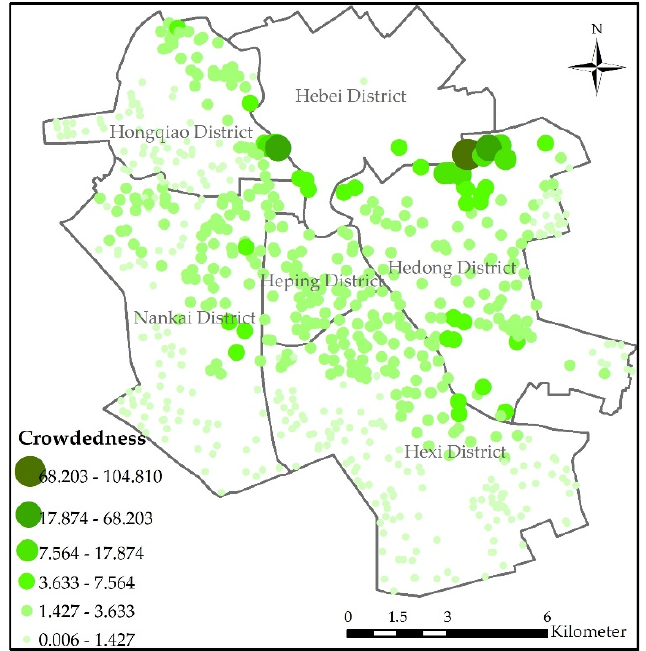
Figure 10. Crowdedness distribution at the end of A-2SFCA’s stage 1 method.